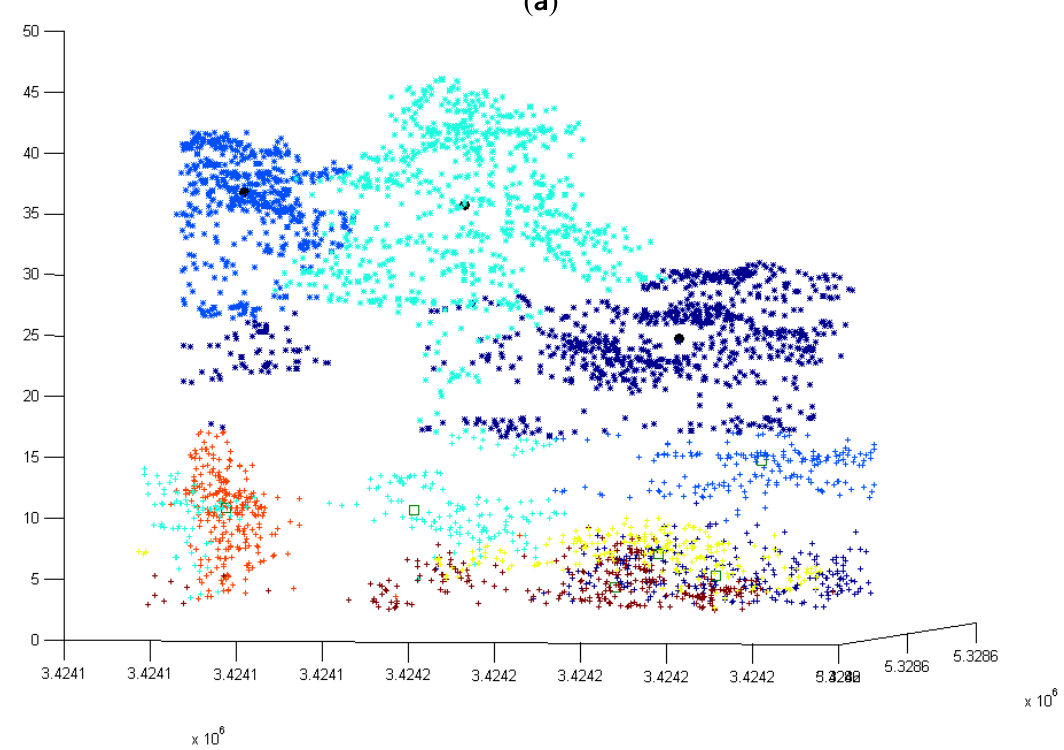
Figure 8. Result after running N k -means without scaling down the height value on two different datasets of Cell 6 at different height levels. (a) Cell 6—clusters from N k -means in 2 height classes (between 2 and 16 m and above 16 m). (b) Cell 6—clusters from N k - means above 16 m height. The x and y coordinate values (in meters) are displayed horizontally and the z value (in meters) is displayed